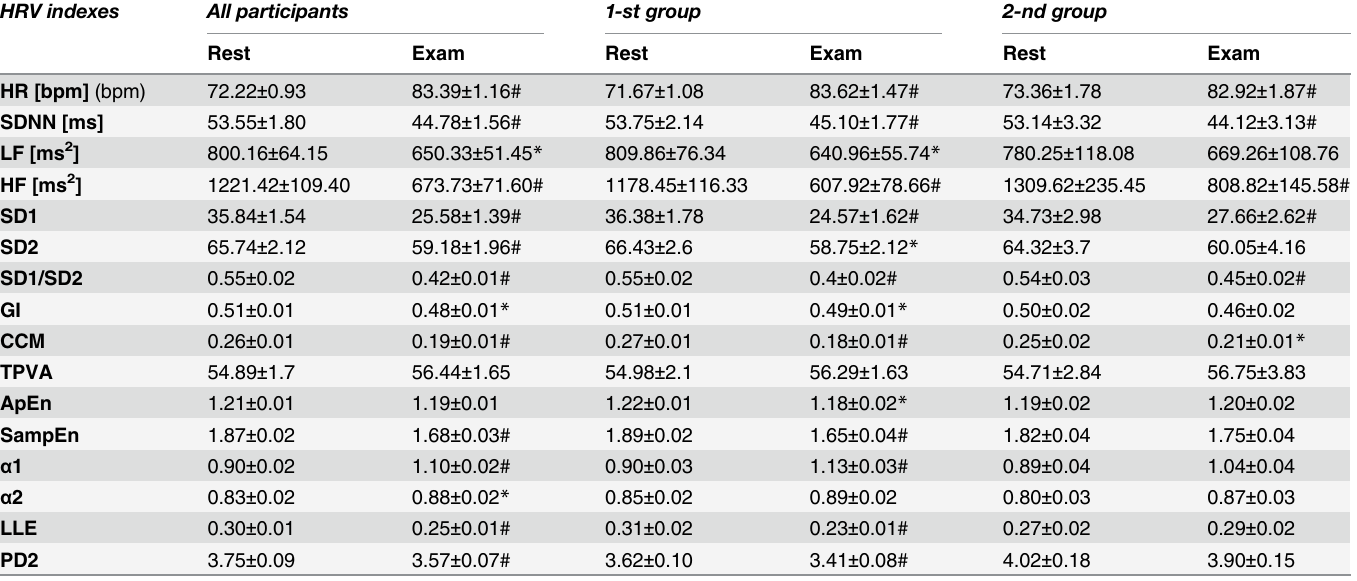
Table 1. Comparison between the two conditions of the study for heart rate variability analysis.